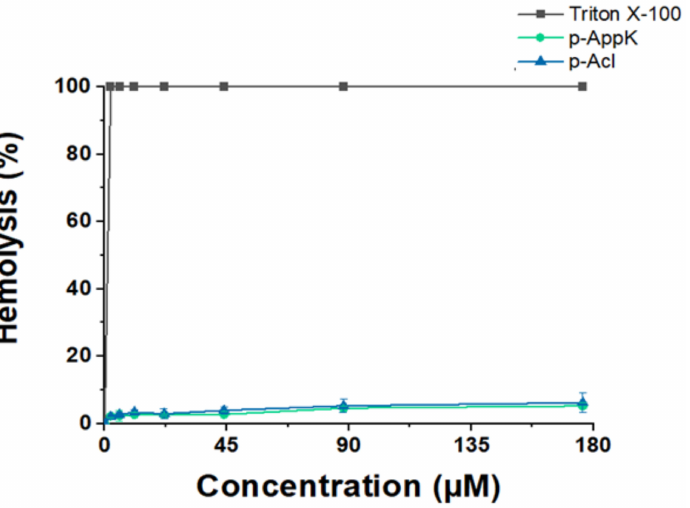
Figure 1. Evaluation of erythrocyte membrane disruption caused by the synthetic peptides. Red blood cells were incubated with 7 different concentrations of p-AppK (blue) and p-Acl (green). The percentage of hemolysis was measured in relation to the effect caused by a hemolytic surfactant, Triton